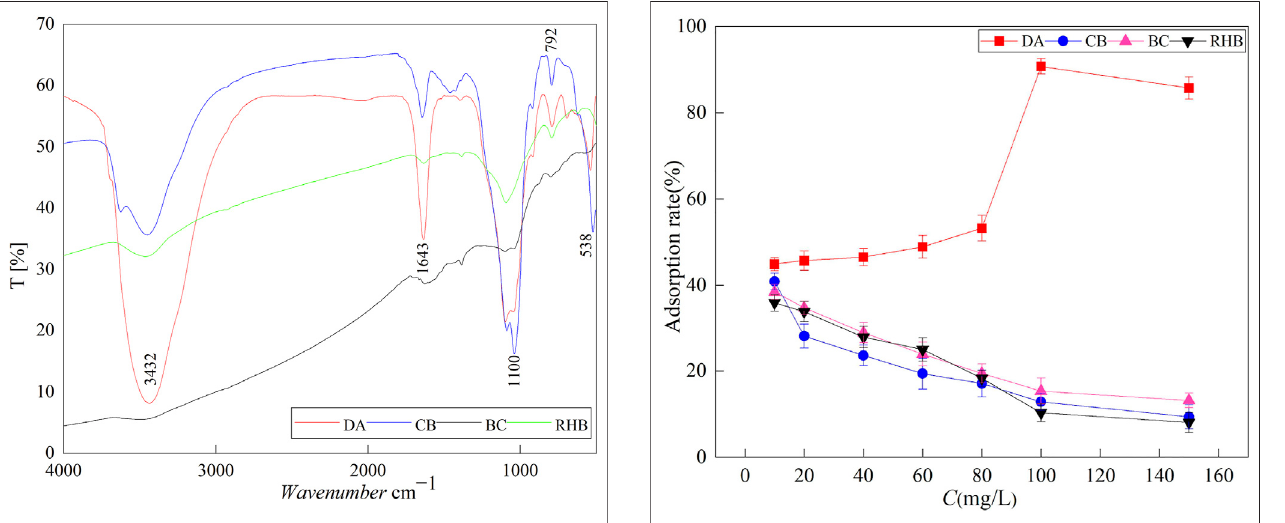
FIGURE4| EffectsoffouradsorbentmaterialsontheadsorptionofanF - solution with different mass